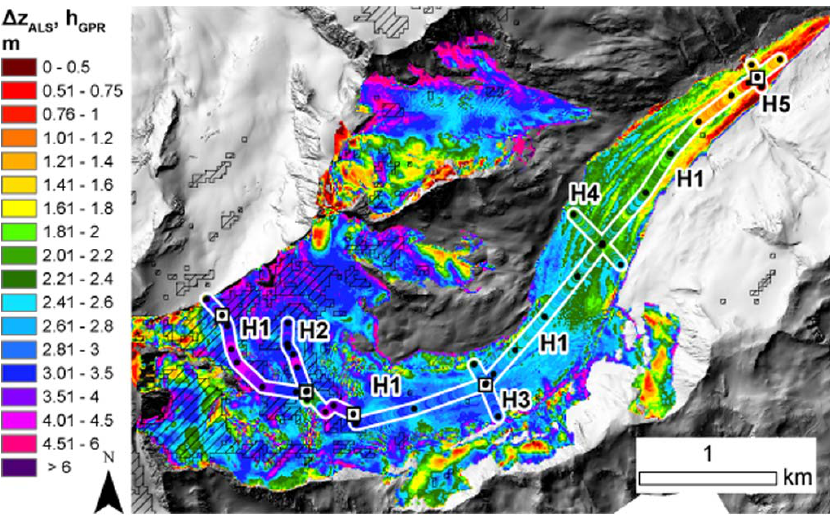
Fig. 8. Spatial distribution of ALS-derived surface elevation changes from 4 October 2011 to 11 May 2012. Snow depths calculated from GPR measurements along the profiles at Hintereisferner shown in the same colour-scale. Black dots indicate locations of snow depth probing. Locations of snow pits are shown as white squares. Snow covered areas derived from Landsat image of 31 August 2009 (LSC) are striped.